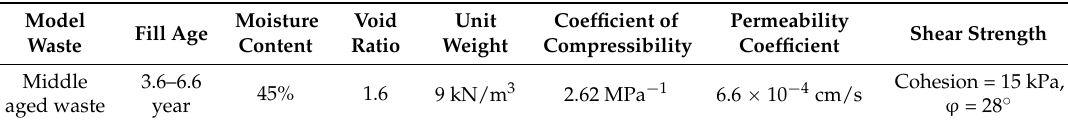
Table 4. Physical properties of model waste.